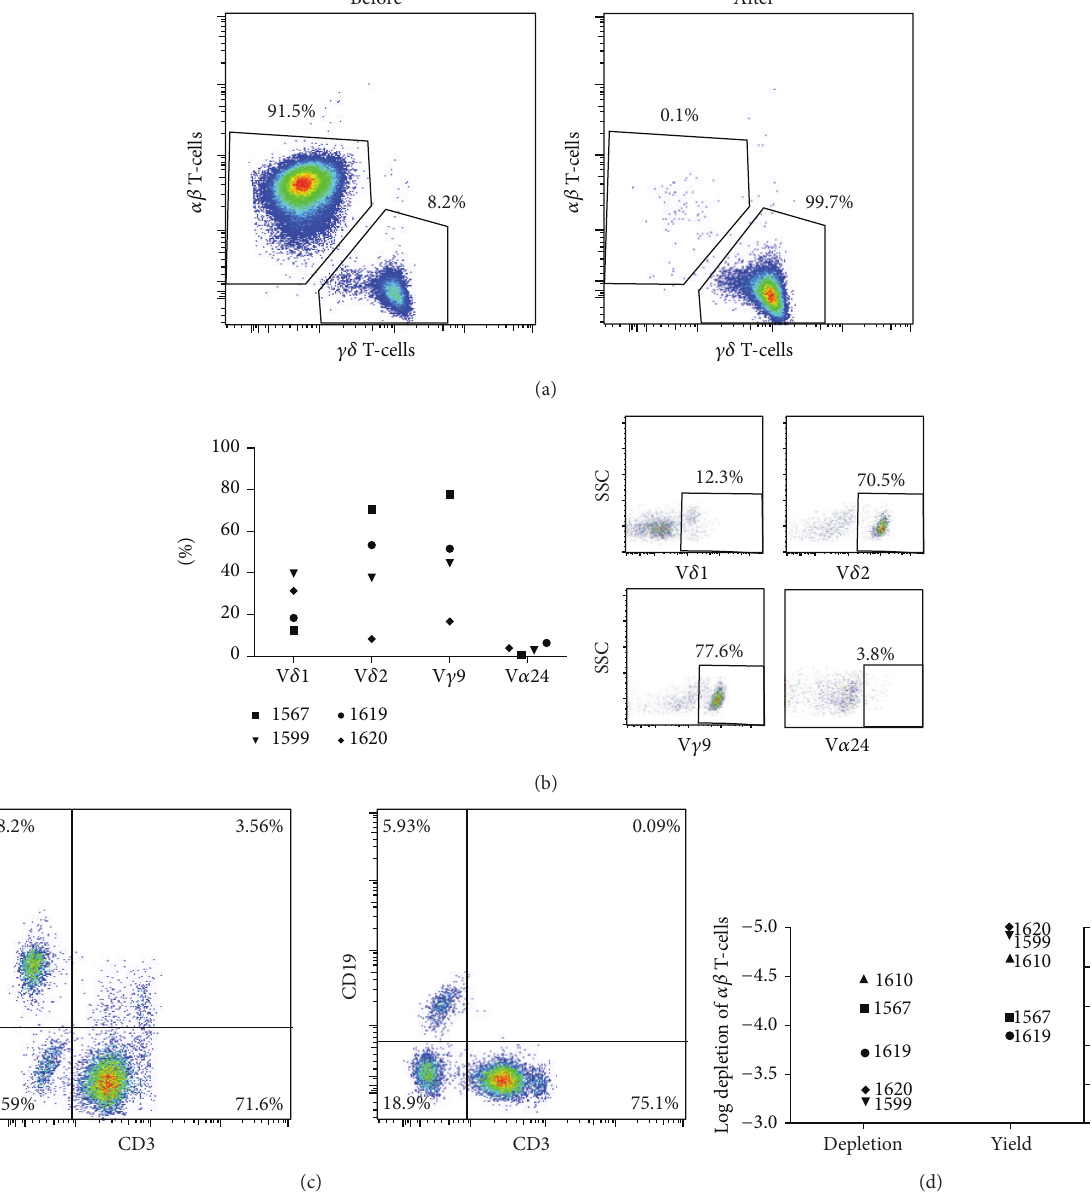
Figure 1: Characteristics of 𝛼𝛽 -depleted graft. Apheresis products were analyzed by flow cytometry before and after 𝛼𝛽 T-cell depletion. (a) A representative plot of 𝛾𝛿 T-cell frequency of the graft before and after 𝛼𝛽 depletion gated from CD45+CD3+ cells. (b) Analysis by flow cytometry was performed on four out of five 𝛼𝛽 -depleted graft samples (the sample from the fifth patient had too few cells for analysis). Subgroups (V 𝛿 1, V 𝛿 2, V 𝛾 9, and V 𝛼 24)+ cells of CD3+ T-cells were analyzed and representative plots from the subsets are shown. V 𝛿 1, V 𝛿 2, and V 𝛾 9 subsets are shown from patient 1567 and V 𝛼 24 subset from patient 1620. (c) Representative plots of B- and NK-cells in the graft after 𝛼𝛽 depletion, gated from CD45+CD19+ or CD45+CD16+/CD56+, respectively. (d) Log depletion of 𝛼𝛽 T-cells and yield/recovery of 𝛾𝛿 T-cells after